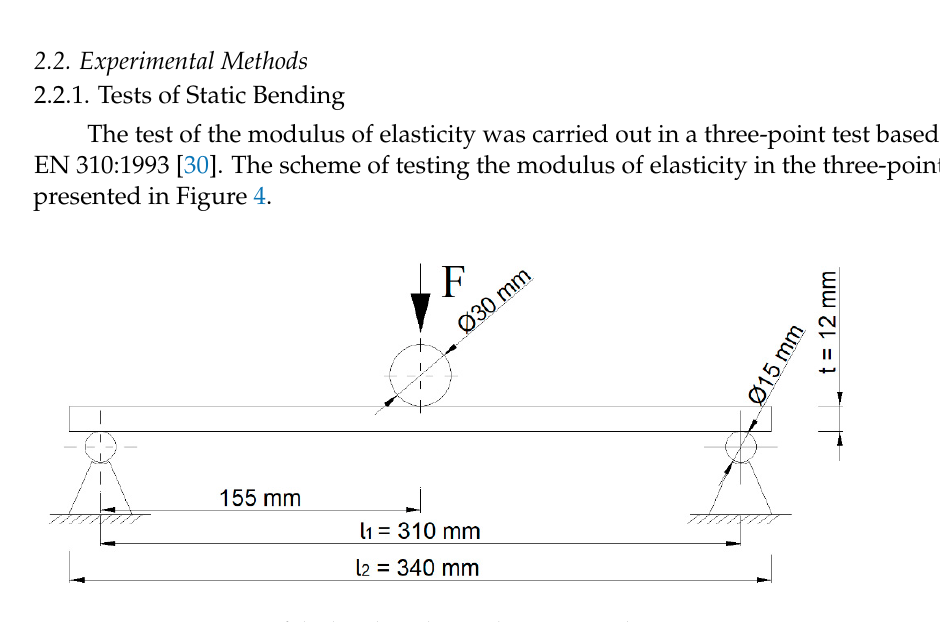
Figure 4. Arrangement of the bending device: l 1 —310 mm, l 2 —340 mm.